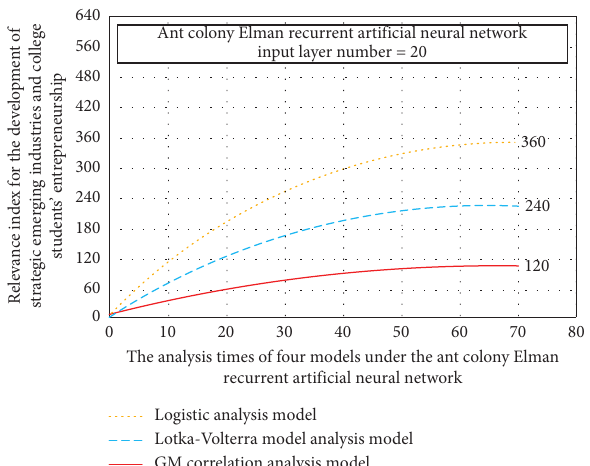
Figure 9: Three models analyze the relationship between the number of times and the development of strategic emerging industries and the correlation index of college students’